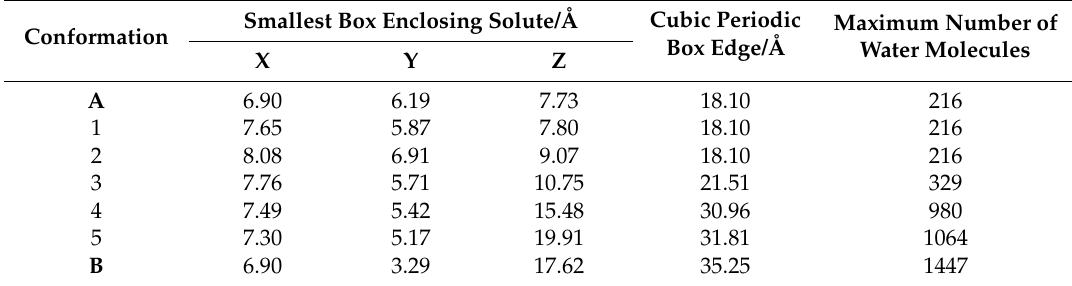
Table 2. Geometric parameters involved in the water box calculations for each conformation obtained from